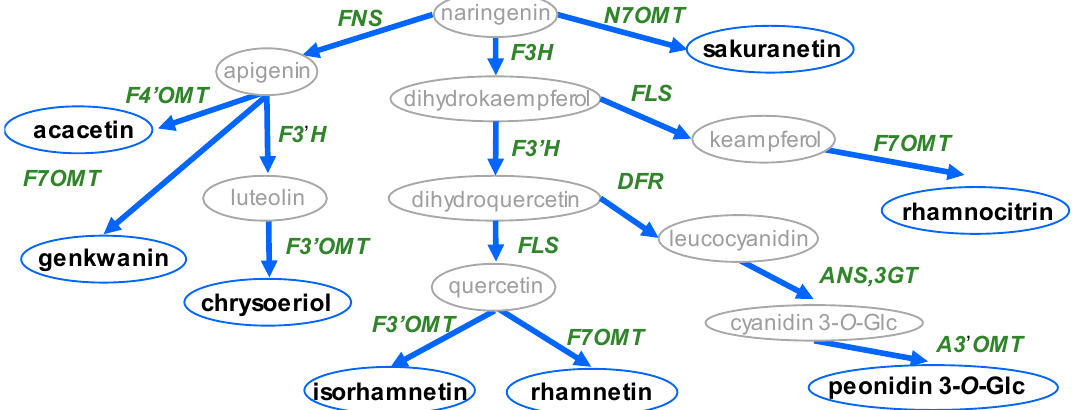
Figure 1. Schematic diagram of known methoxylated flavonoid aglycone biosynthesis. Circles indicate metabolite name, arrows indicate biosynthesis pathway, and words in italics indicate biosyn-